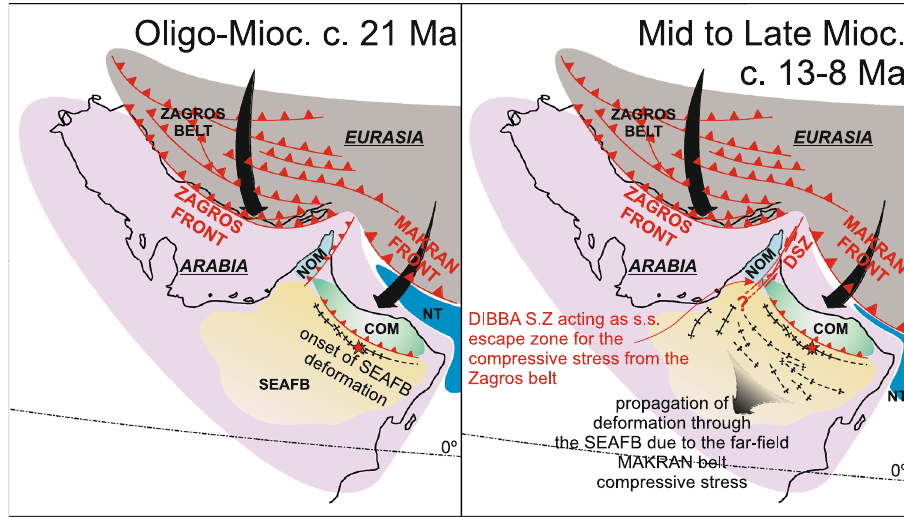
Figure 9. Schematic model of the geodynamic evolution of the Arabia-Eurasia collision from the early to Late Miocene. Position of the continental margins, subduction zones and the tectonic structures in the Zagros and Makran belts and in Iran are from 3,51 . Tectonic structures in the UAE and Oman are from 6,52,53,62 . The extent of the offshore Semail Ophiolite is unconstrained. NOM northern Oman mountains, COM central Oman mountains, DSZ Dibba shear zone, NT Neotethys; red star shows the location of the study